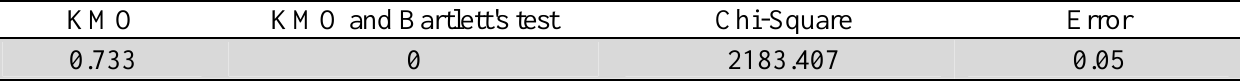
The summary of KMO and Bartlett's test